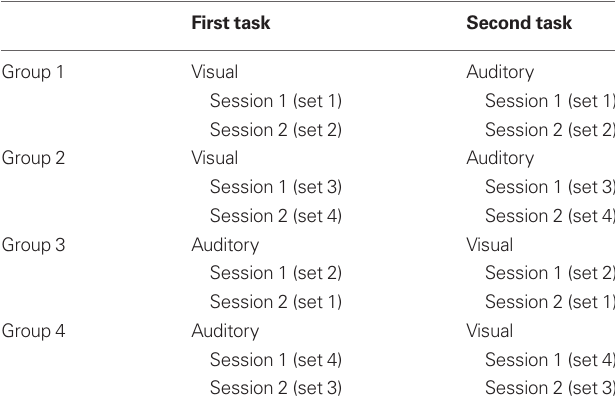
Table 1 | Experimental